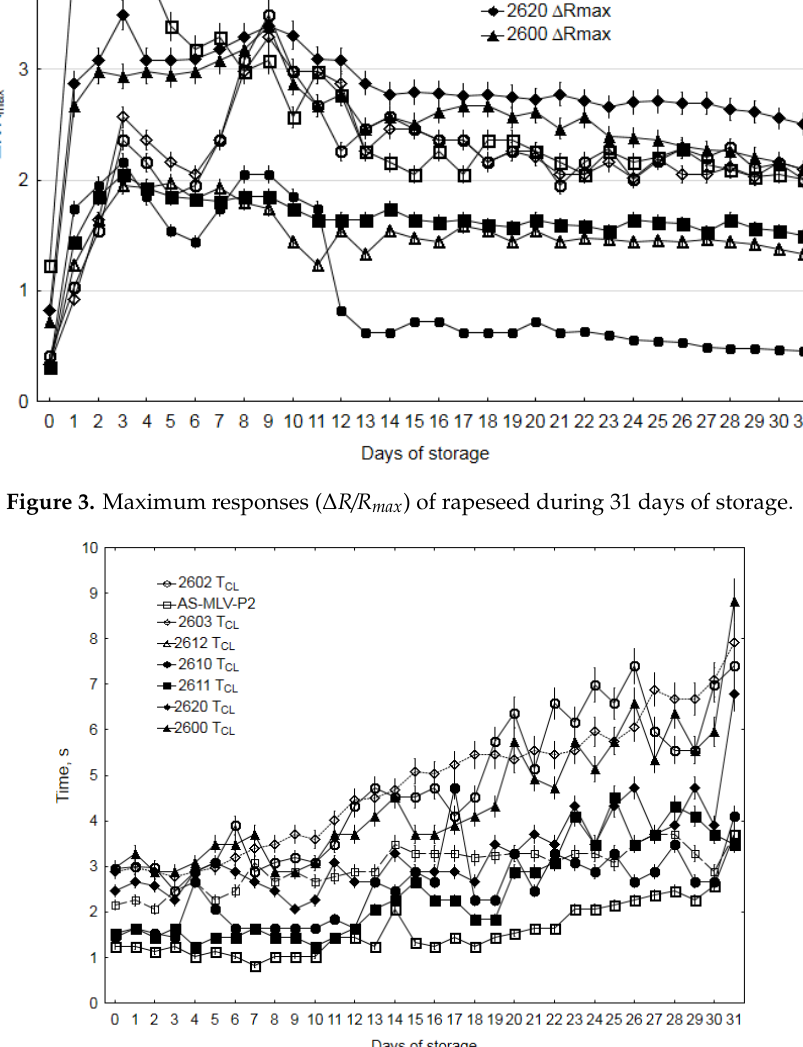
Figure 3. Maximum responses (  R/R max ) of rapeseed during 31 days of storage.